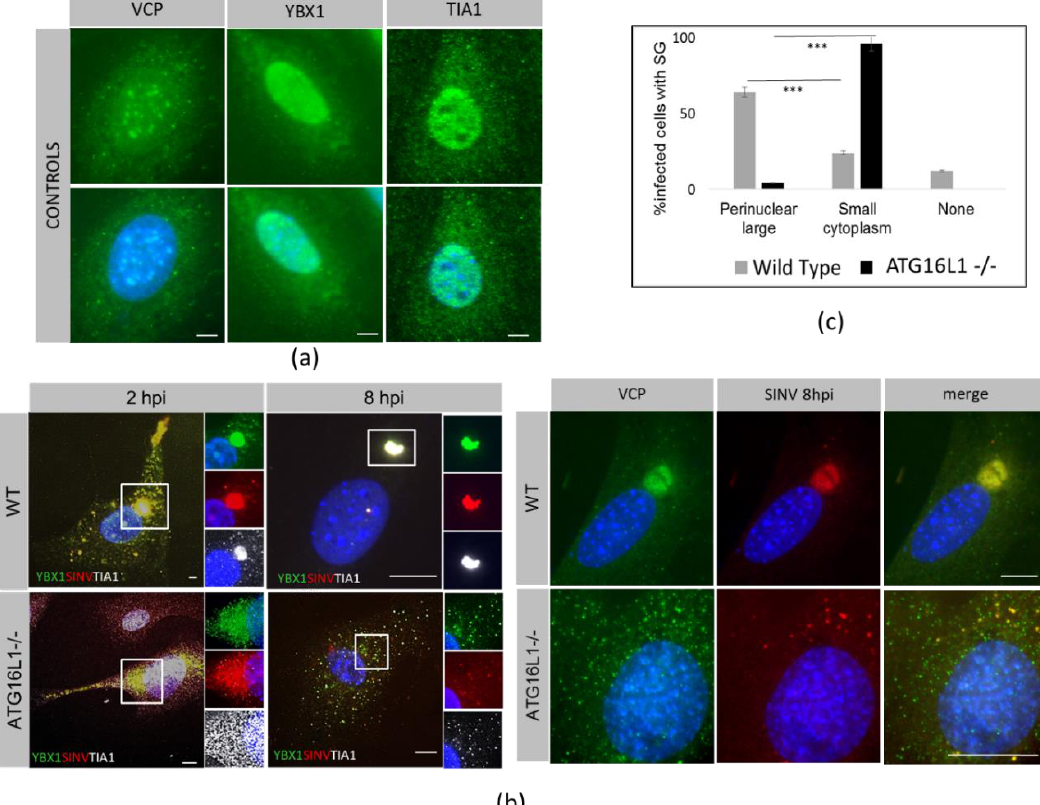
Figure 3. Perinuclear stress granules do not form in ATG16L1-/-cells.Host proteins YBX1, TIA1 and VCP were stained in WT and ATG16L1-/- MEF cells. ( a ) distribution in ATG16L1 uninfected cells. ( b ) distribution of host proteins in WT and ATG16L1 MEFs cells infected with SINV mCh.capsid for 2 and 8 hpi. ( c ) The bar chart shows percentage of infected cells with either large perinuclear SG or small cytoplasmic puncta from 5 independent fields of view of WT and ATG16L1-/- cells at 8hpi at 40× magnification. +/- SE and *** p < 0.001. None indicates a small number of infected cells with no SG.